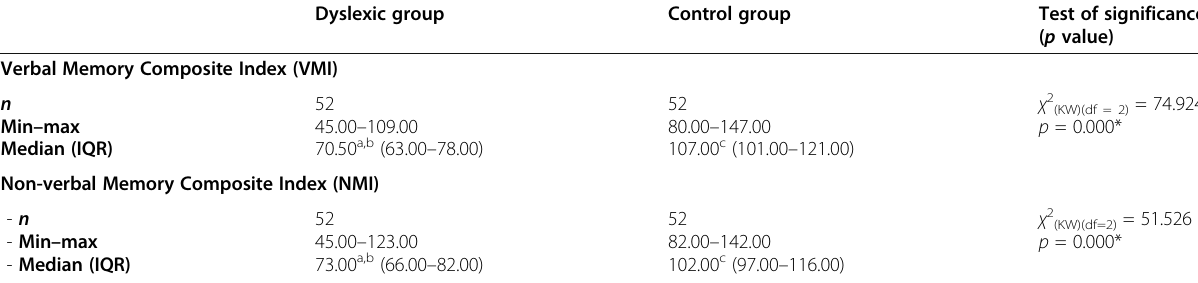
Table 1 Comparison between the two studied groups according to the core subtests Dyslexic group Control group Test of significance